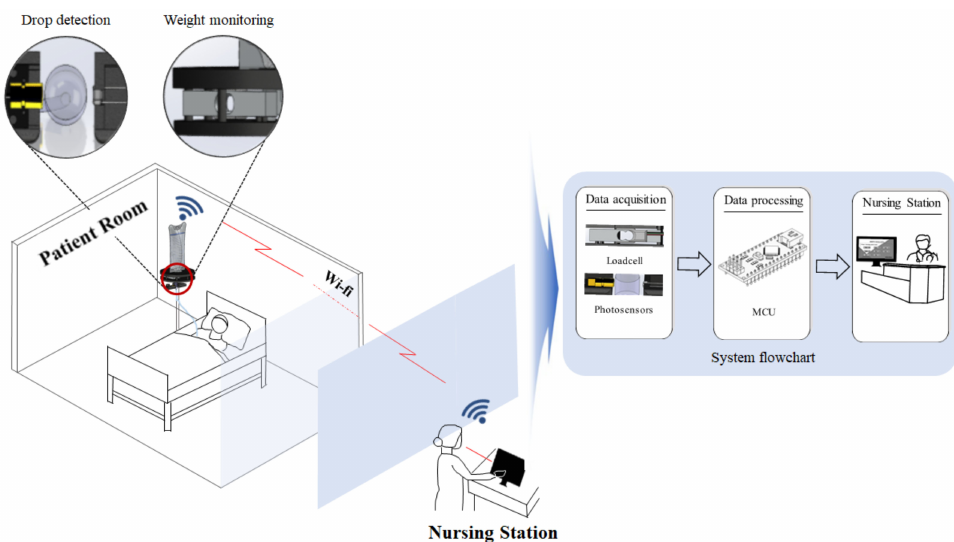
Figure 1. Work process and communication between the proposed system and mobile devices via Wi-Fi.